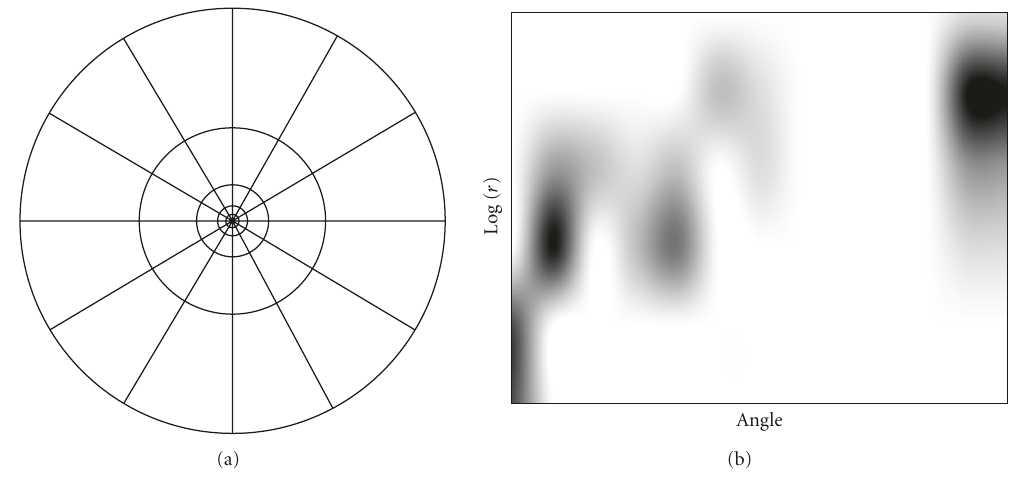
Figure 2: log-polar histogram bins and a shape context for one feature point.